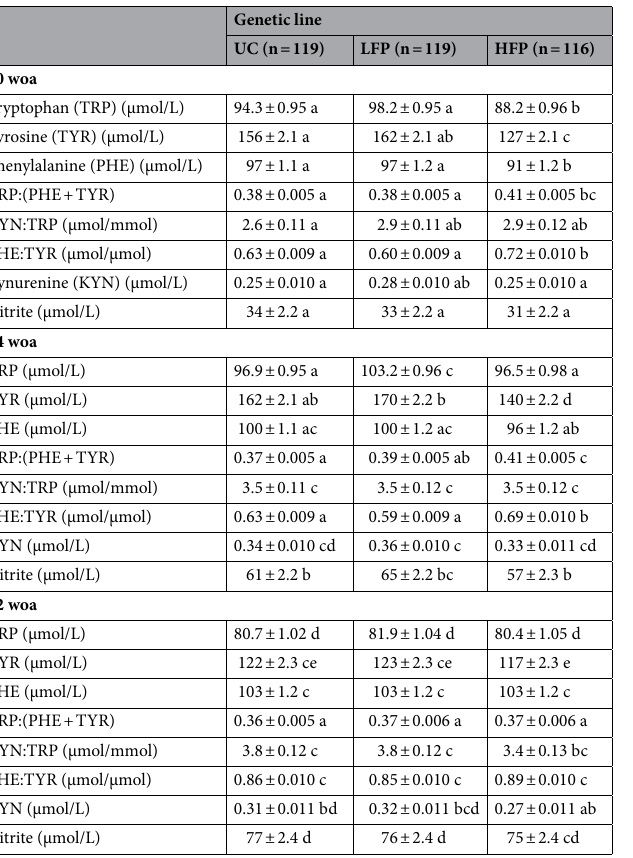
Table 3. Least Squares Means (± Standard Error) of aromatic amino acids, kynurenine and nitrite in birds at 10, 14 and 32 weeks of age (woa) (n of birds: UC = 119, LFP = 119, HFP = 116, whereby LFP low feather pecking line; HFP high feather pecking line; UC unselected control line). Different letters indicate statistically significant differences across lines within each time point and across time points within each line for each variable (P <